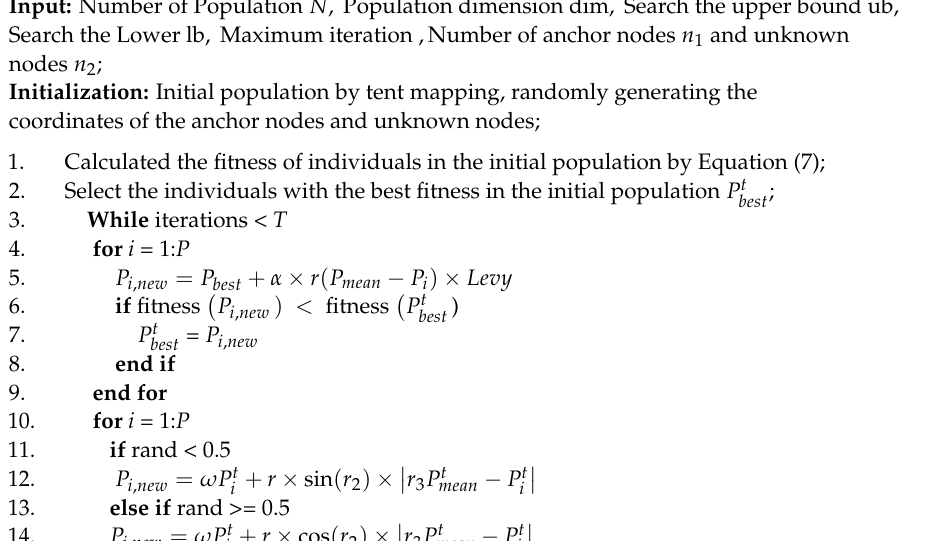
Algorithm 1: Pseudo code of HBES-based TDOA positioning